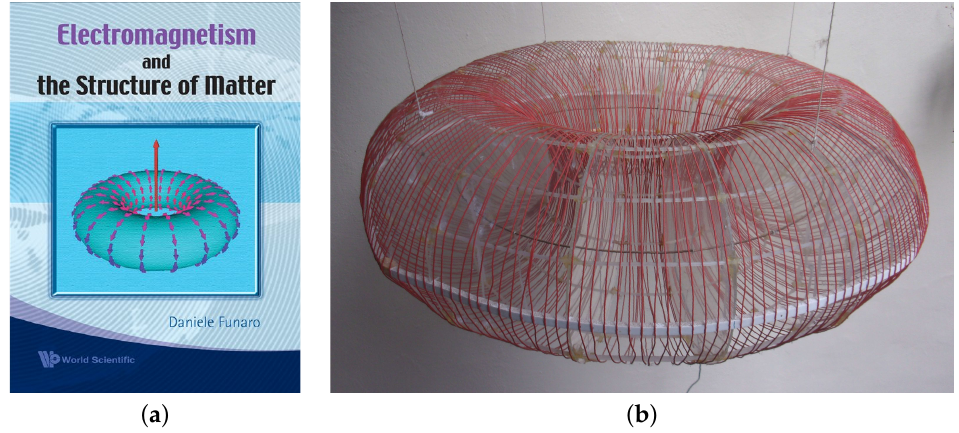
Figure 10. The cover of the book ( a ) and an archaic version of the ring ( b